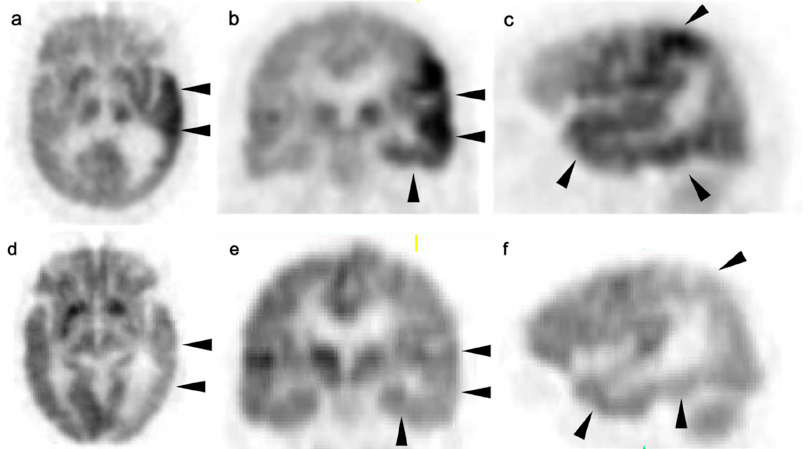
Figure 36. Mental status changes in a patient being treated for an underlying malignancy, proving to be herpes simplex encephalitis (HSE) at biopsy. ( a – c ) Increased metabolic activity in the left temporal lobe is typical for acute phase of HSE (black arrowheads). ( d – f ) Repeat PET-CT 6 months following recovery of HSE shows resultant decreased metabolic activity due to neuronal damage (black arrowheads). Viral encephalitis can mimic either paraneoplastic encephalitis or primary brain tumor on FDG PET.